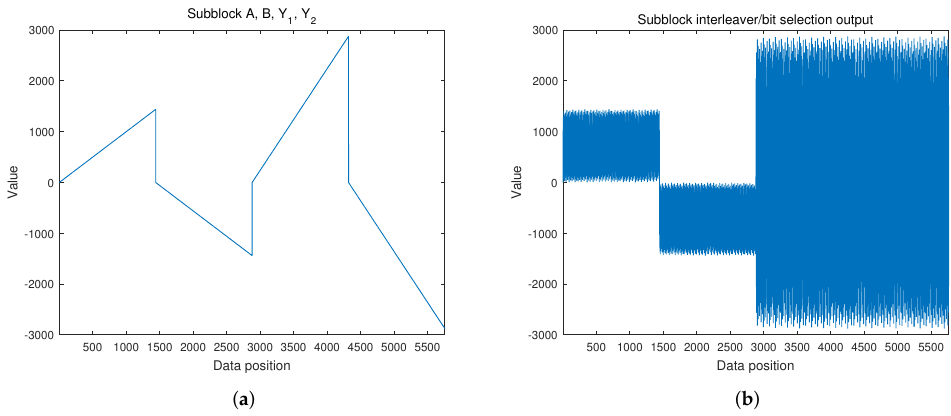
Figure 3. Subblock interleaver and bit selection block: ( a ) test input; and ( b )